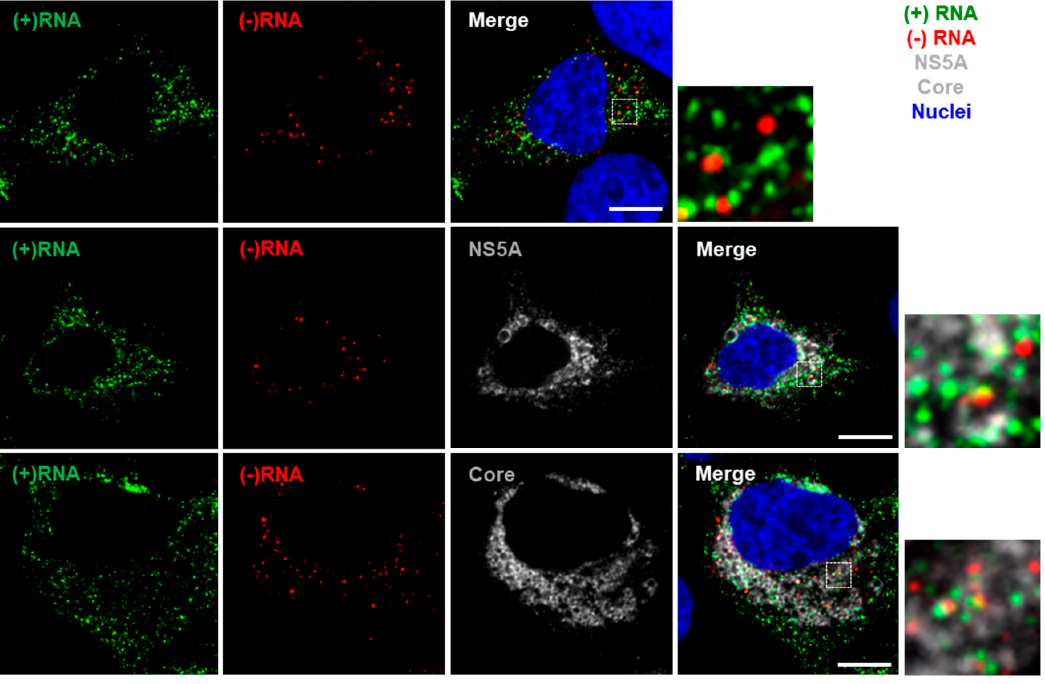
Figure 4. Multiplex imaging of both (+) and ( − )RNA strands and protein in HCV-infected cells. Huh-7.5.1 cells were infected with HCV Jc1/Gluc2A at a multiplicity of infection (MOI) of 0.5. After 48 h, cells were fixed and probed sequentially for ( − )RNA (red), (+)RNA (green) and viral protein (white). Finally, nuclei were stained with DAPI (blue). Cells were imaged on a Leica SP8 confocal microscope using a 63× oil-immersion objective. Boxed regions shown enlarged. Scale bars represent 10 µm.